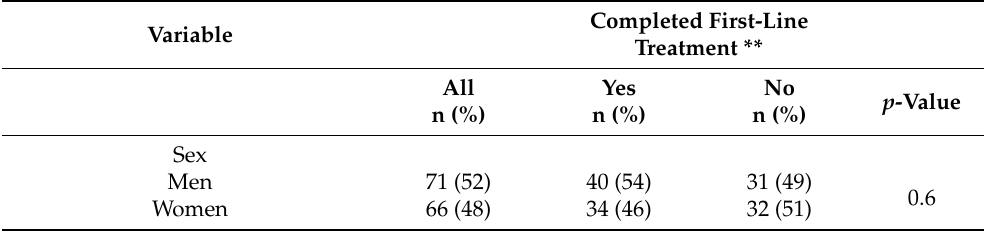
Table 1. Study population characteristics of 137 newly referred lung cancer patients in the PACO2 study, Herlev University Hospital, Denmark, 2016–2017.